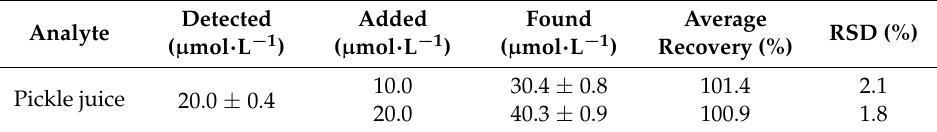
Table 2. Detection of nitrite in pickled juice samples (n =